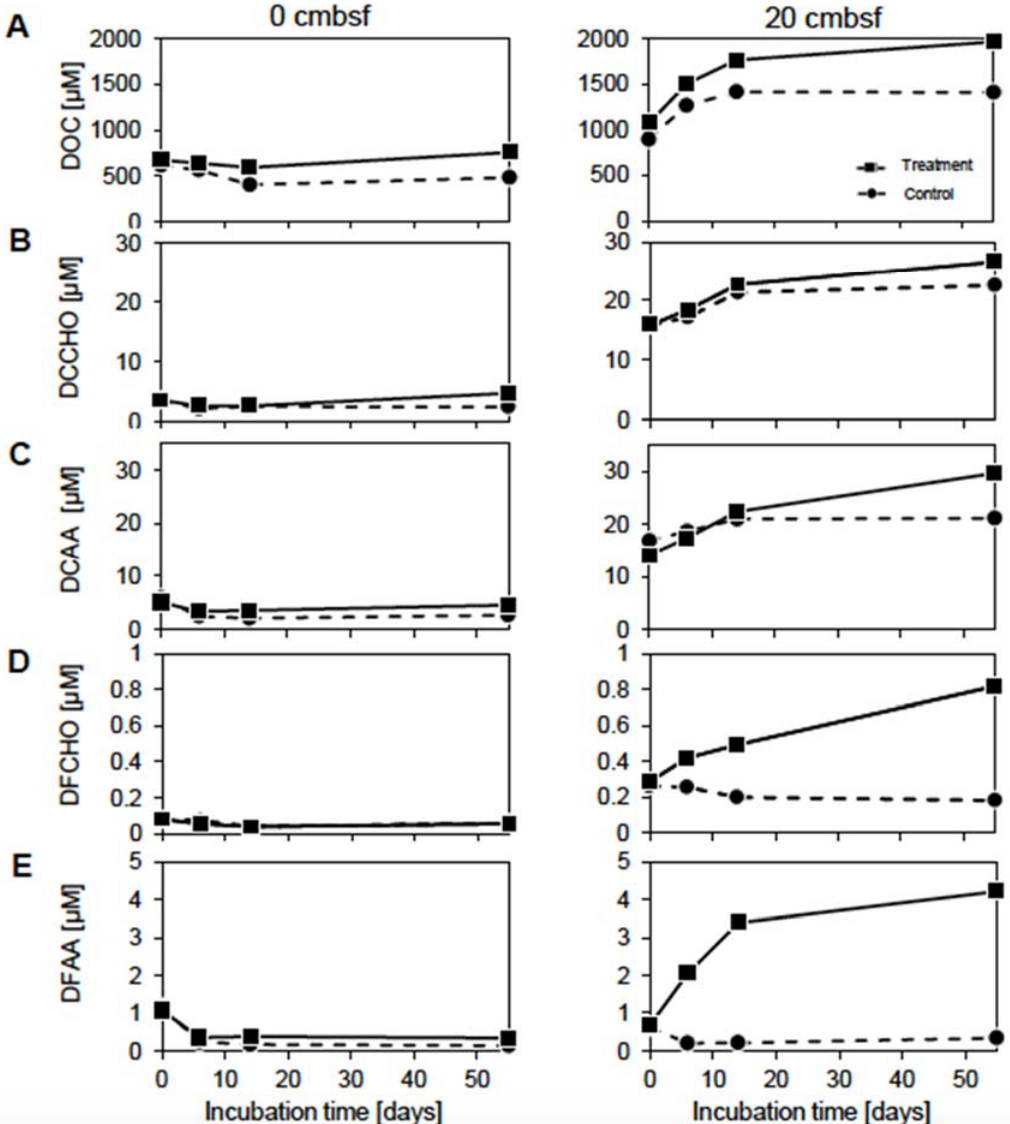
Figure 2. Dynamics of selected organic carbon compounds: ( A ) DOC, ( B ) dissolved combined carbohydrate, ( C ) dissolved combined amino acid, ( D ) dissolved free carbohydrate and ( E ) dissolved free amino acid concentrations. Lleft column 0 cmbsf and right column 20 cmbsf slurries. The mitomycin C treated incubations are displayed by the solid line and squares, the non ‐ treated controls by the dashed line and circles.